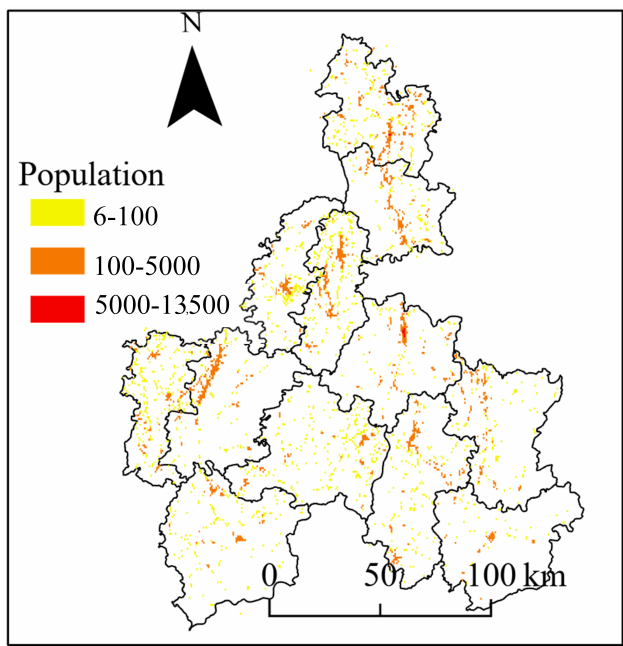
Figure 7. Distribution of grid-level population data.